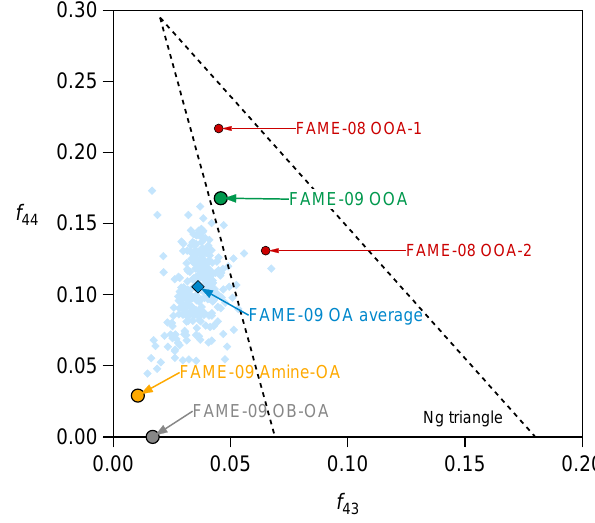
Fig. 12. Organic aerosol composition in the Ng et al. (2010) tri- angle plot: f 44 (the fraction of total organic signal due to ions at m/z 44) vs. f 43 . OOA during FAME-09 and FAME-08 fall within the triangle. Average bulk OA composition during FAME-09 (large blue rhombus) falls outside of the triangle due to the influence of Amine-OA and OB-OA. Small blue rhombi are 2h-averages of the bulk OA composition during